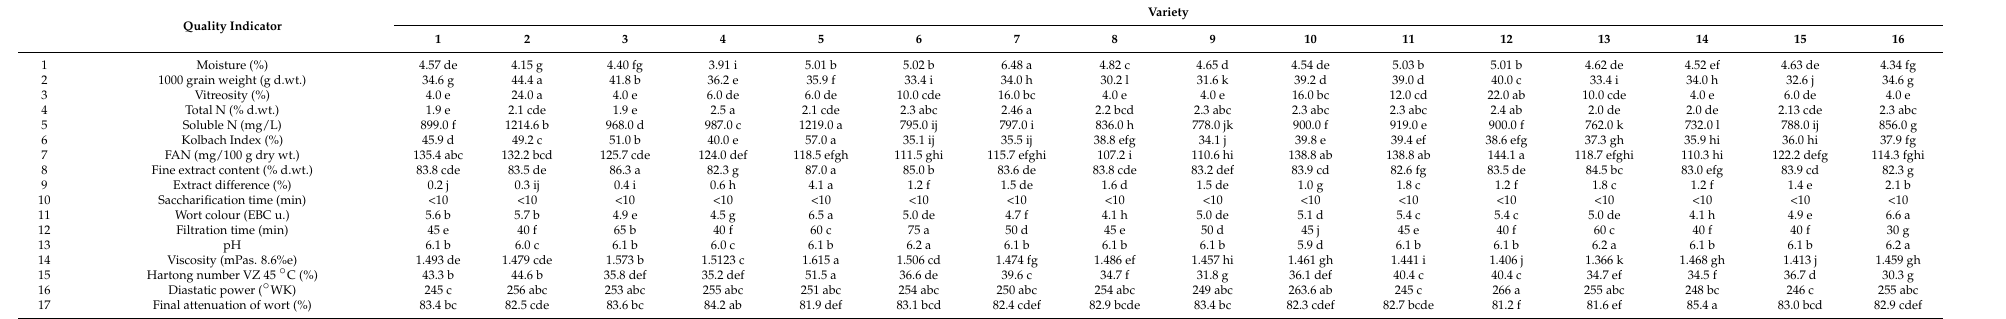
Values are means of two measurements. Values displayed in the same lines and tagged with different letters are significantly different ( p <